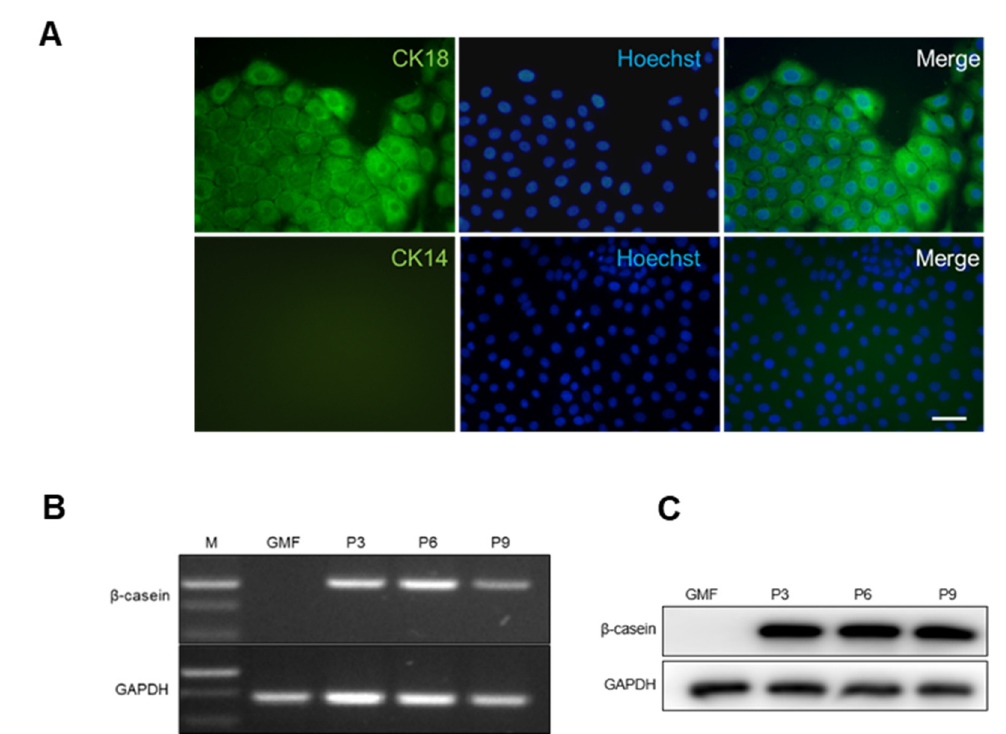
Figure A2. GMECs expressed cytokeratin (CK) 18 and β -casein. ( A ) GMECs expressed CK18, not expressed CK14. ( B ) β -casein mRNA expression; ( C ) β -casein protein expression. GMF = goat mammary fibroblasts; P3, P6, P9 = GMECs passaged 3, 6, 9 times. (original western blot figures in Figure S11). Scale bar = 50 µ m.